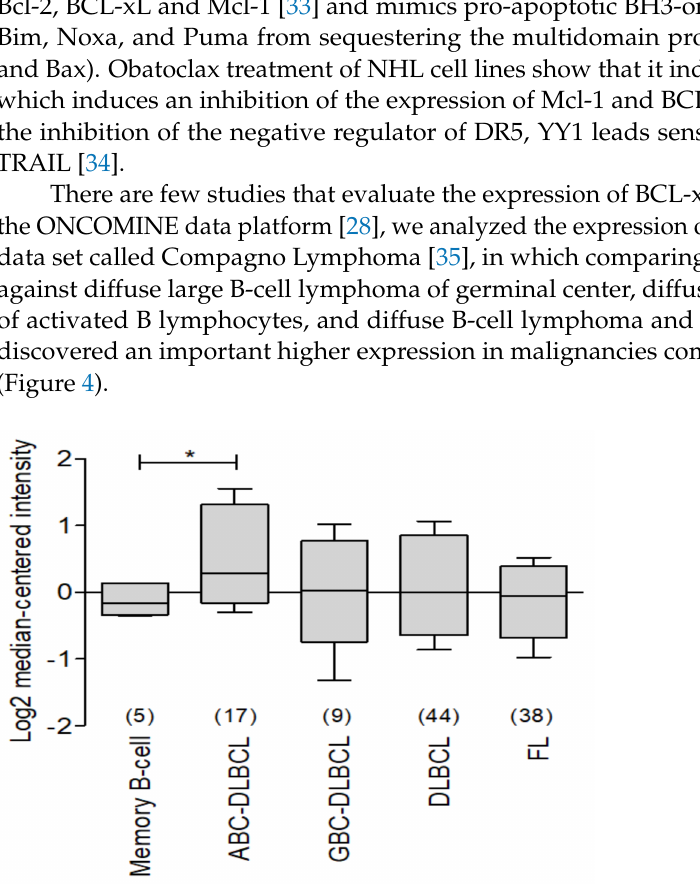
Figure 4. Analysis of BCL-xL expression in different subtypes of non-Hodgkin’s lymphoma. ON- COMINE BCL-xL expression was revised in Compagno Lymphoma [35]. An important expression of BCL-XL was observed in different subtypes of lymphoma versus memory B-cell used as control (* p <